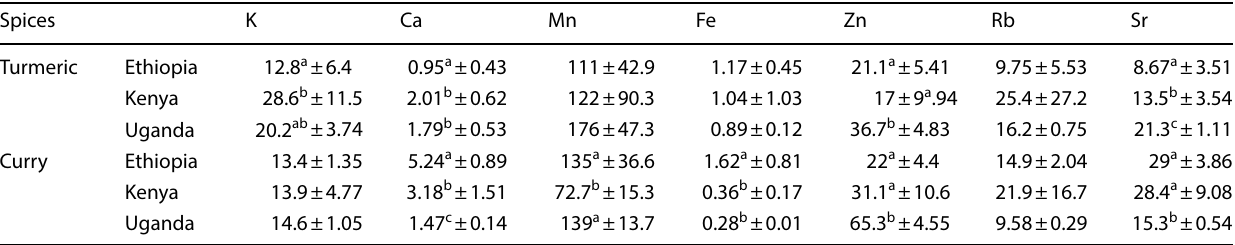
Table 1 Statistics of elemental concentrations in turmeric and curry powder samples (mean ± SD) by their geographic origins. K, Ca and Fe are reported in g kg −1 and values are given in mg kg −1 for Mn, Zn, Rb and Sr